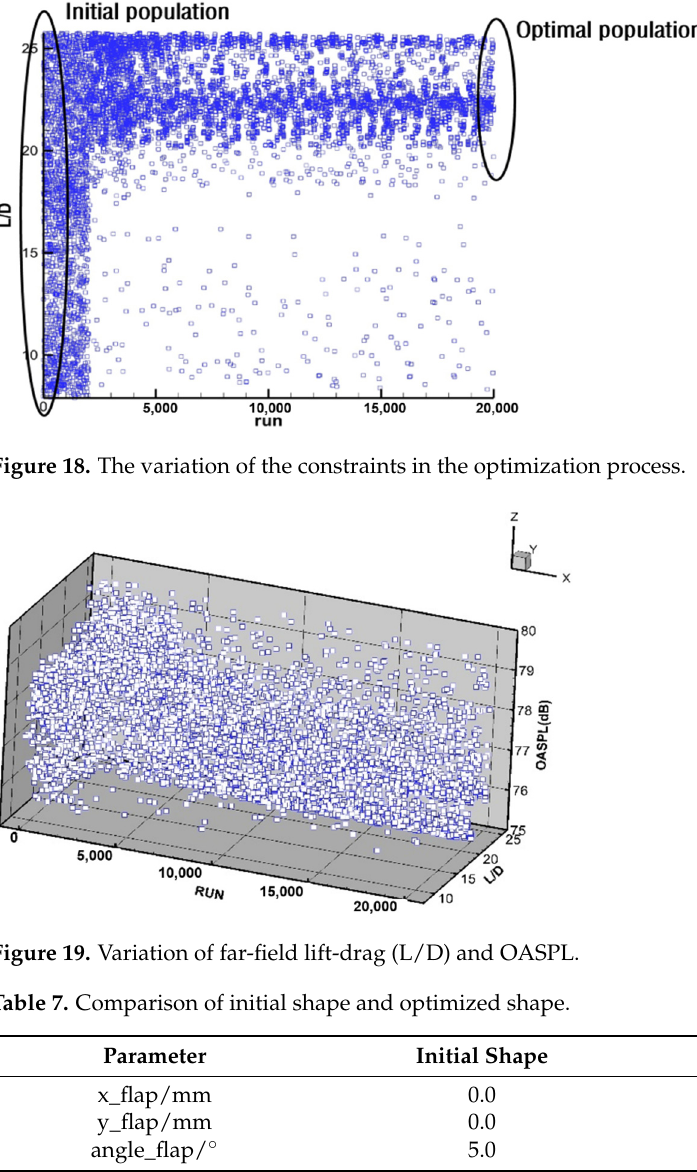
Figure 17. Variation of objectives in optimization process.